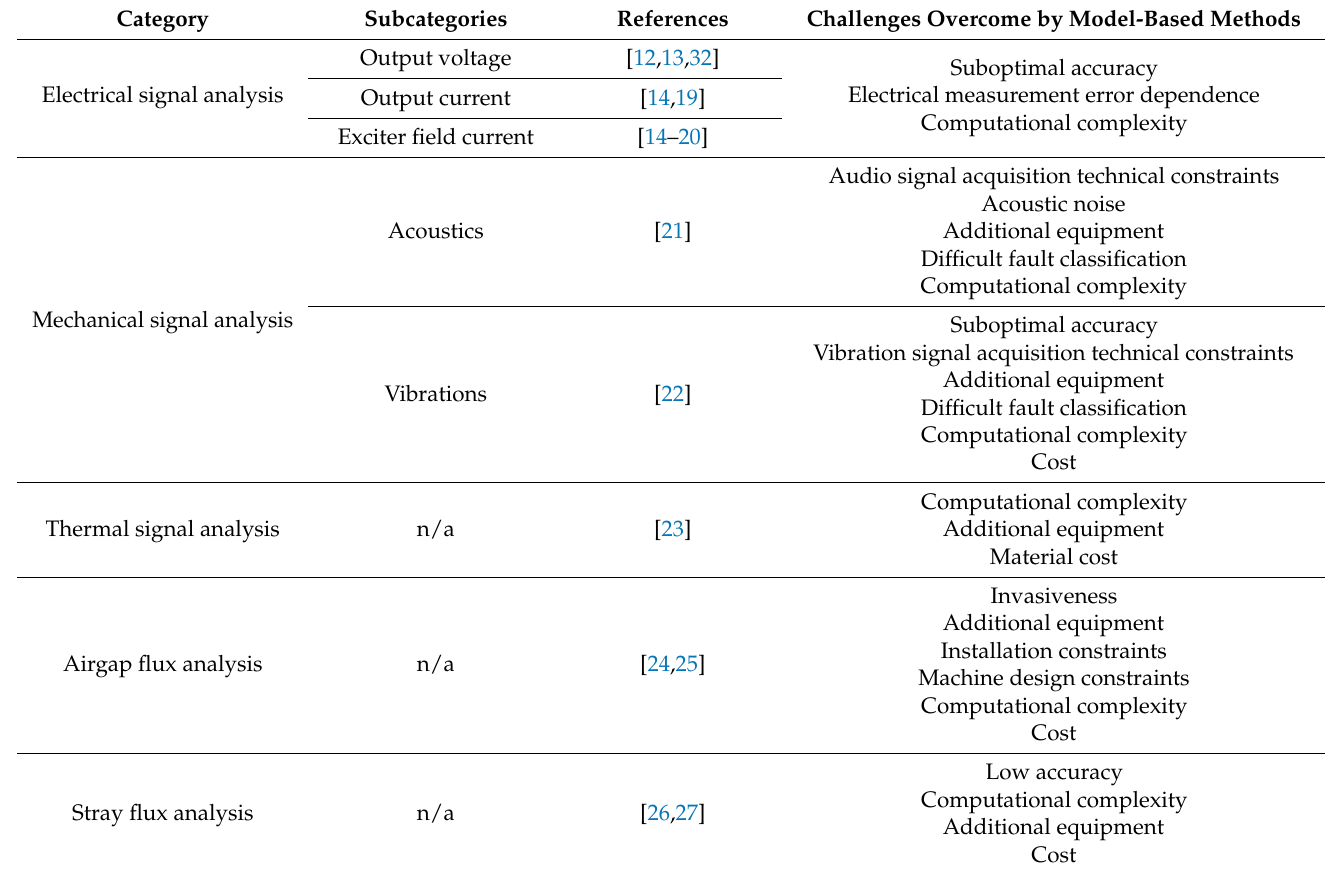
Table 1. Comparison of various online BSM rotating rectifier fault